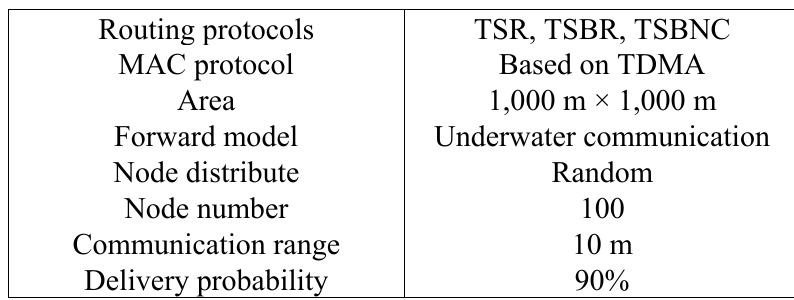
Table 1. Simulation parameters.